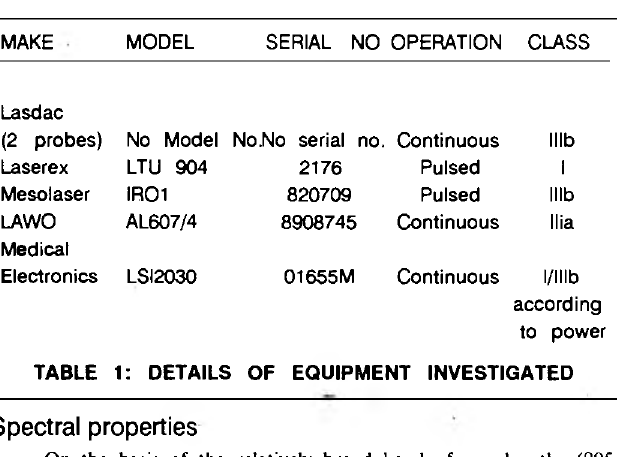
TABLE 2: SPECTRAL PROPERTIES OF DIFFERENT